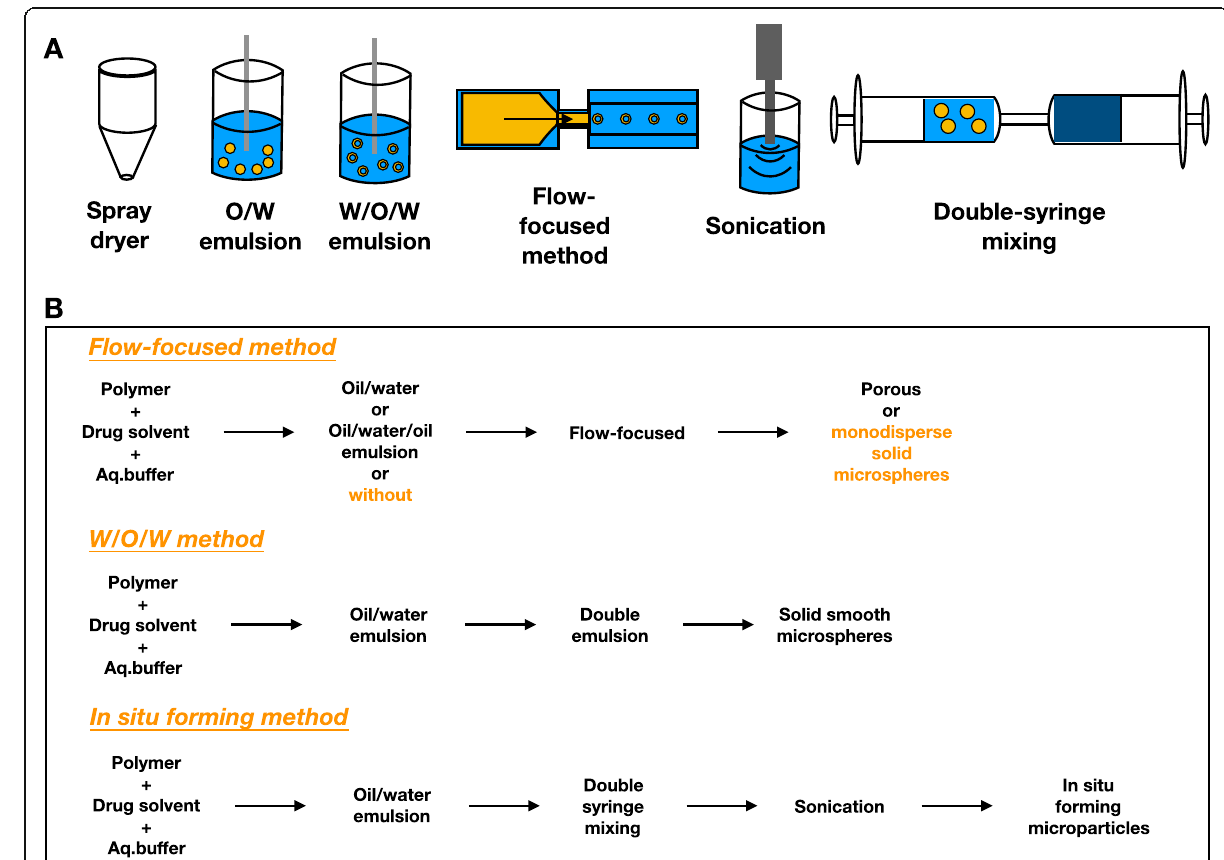
Fig. 2 Classical techniques of producing liposomes. a Basic production techniques for liposomes. b Demonstrations of production